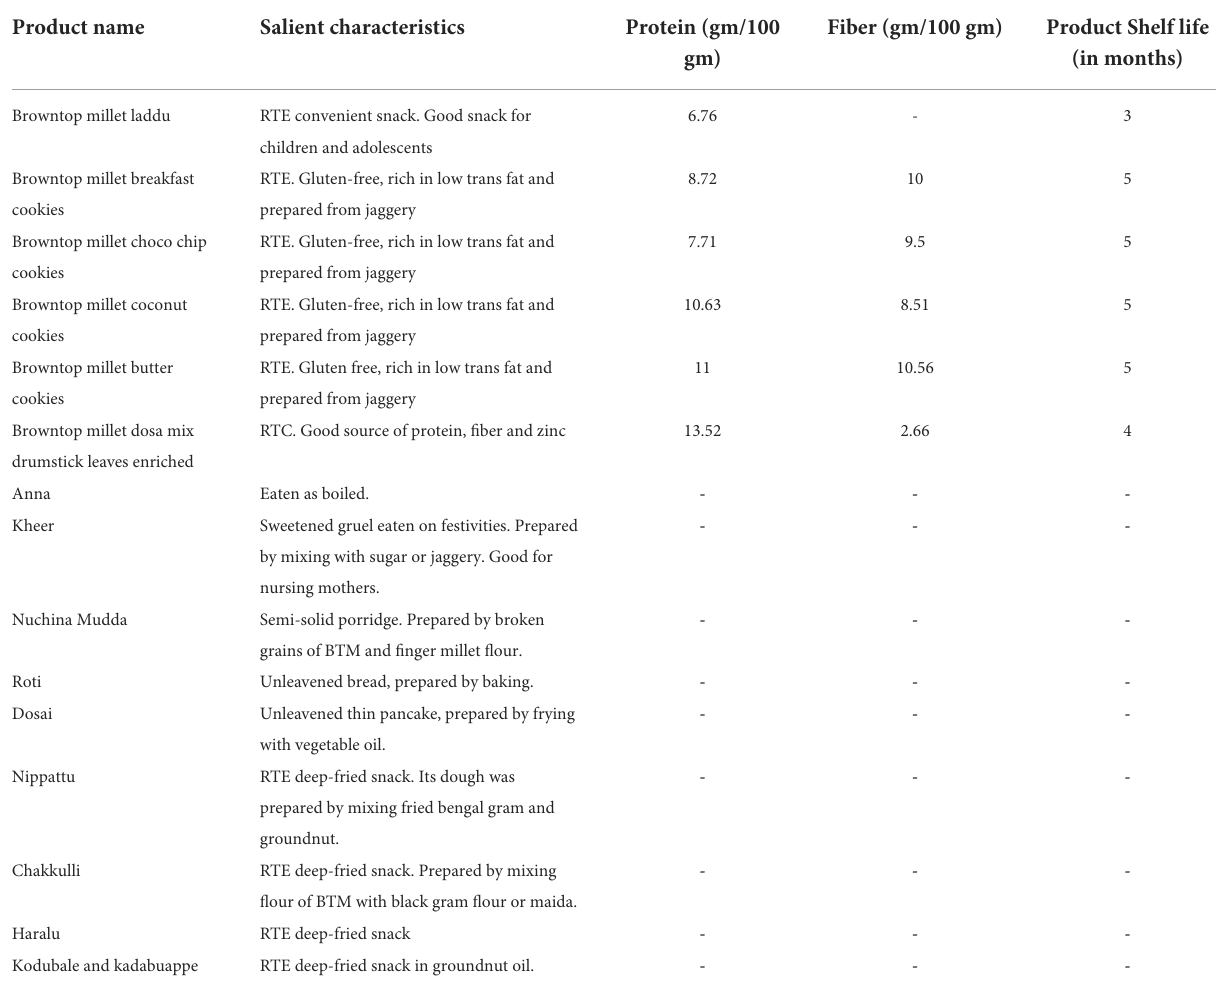
TABLE 6 Salient value added food products prepared from browntop